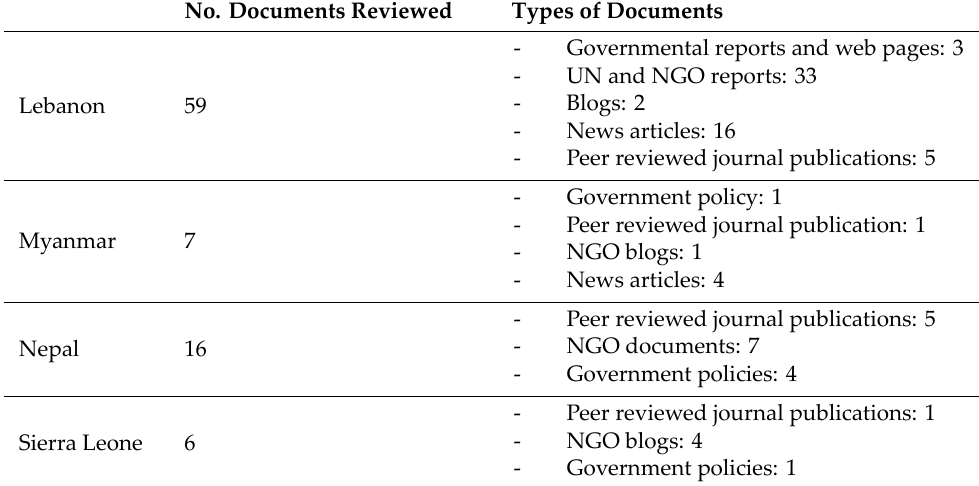
Table 3. Documents reviewed in each